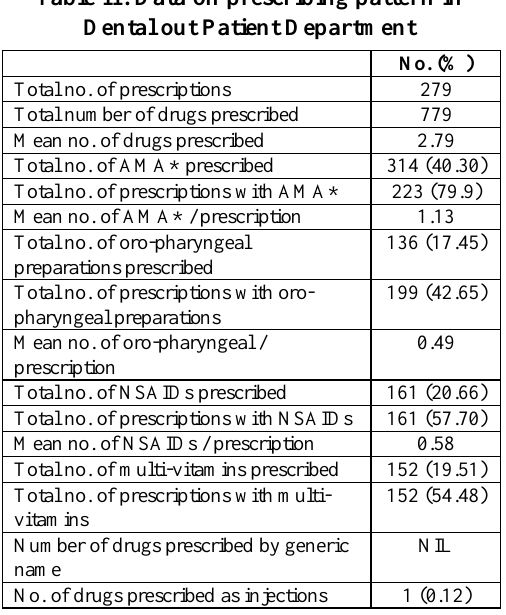
Table II. Data on prescribing pattern in Dental out Patient Department